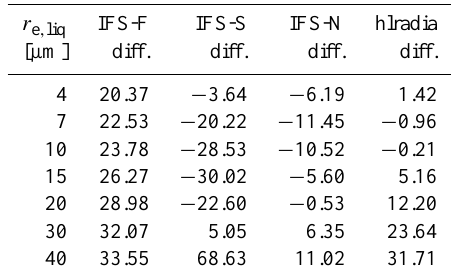
Table 6. As for Table 5 but for experiment 5 absolute differences in Wm − 2